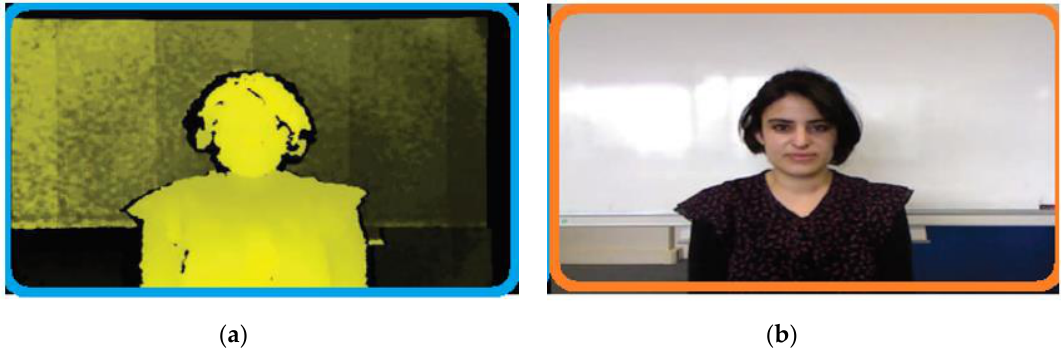
Figure 31. RGB-D (red green blue-depth) alignment: ( a ) the depth map is aligned with ( b ) the RGB image captured by Kinect at the same time.